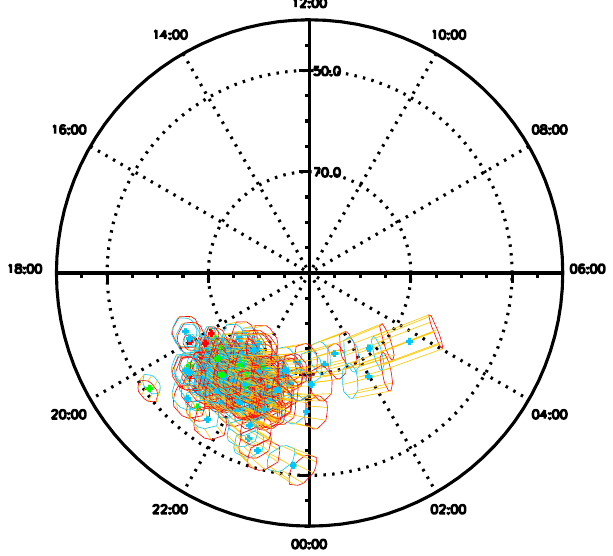
Fig. 3. Distribution of AKR burst locations and uncertainty el- lipses in CGM coordinates for VLBI observations on 28 October 2003 from 10:41–11:06 UT. Frequency codes of the dots are red (125kHz band), green (250kHz band), and blue (500kHz band); the projected cylindrical tapered prisms are the uncertainty volumes for each enclosed dot. The AKR burst locations are projected to 100km altitude.